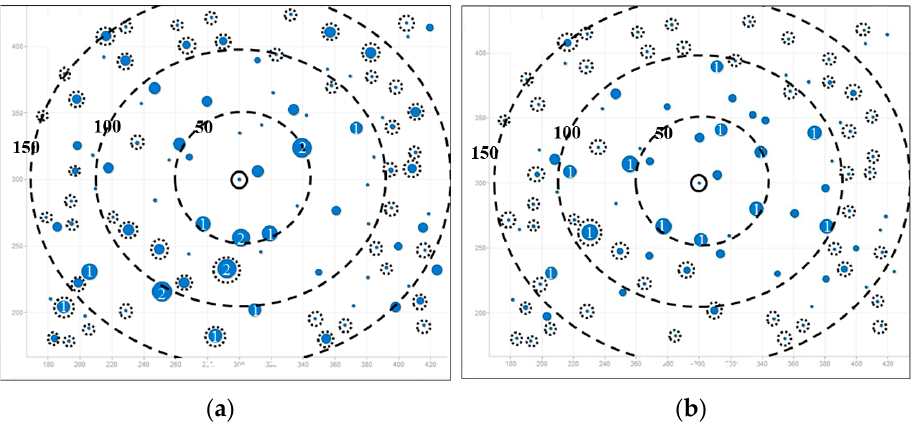
Figure 7. Load distribution in random topology (total node is 100). ( a ) AOMDV; ( b ) LBMR.